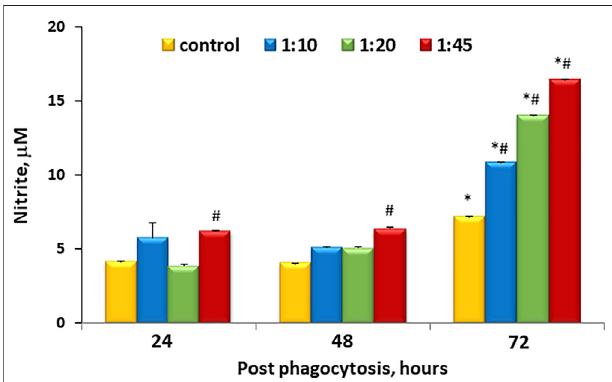
FIGURE 2 | Dose-dependent microcapsule loading increases nitrite levels and cell activation. Cells were incubated with microcapsules at various ratios (1:0, 1:10, 1:20, and 1:45) and cultured for 24, 48, or 72 h post- phagocytosis; at the indicated time points, the supernatant media were collected and analyzed for nitrite content via cyclic voltammetry. Each sample was measured 3 – 5 times, n = 3 per each conditions and time points. * r < .05 versus the corresponding cell/microcapsule ratio at 24 h post phagocytosis; # p < .05 versus control at the same time point.